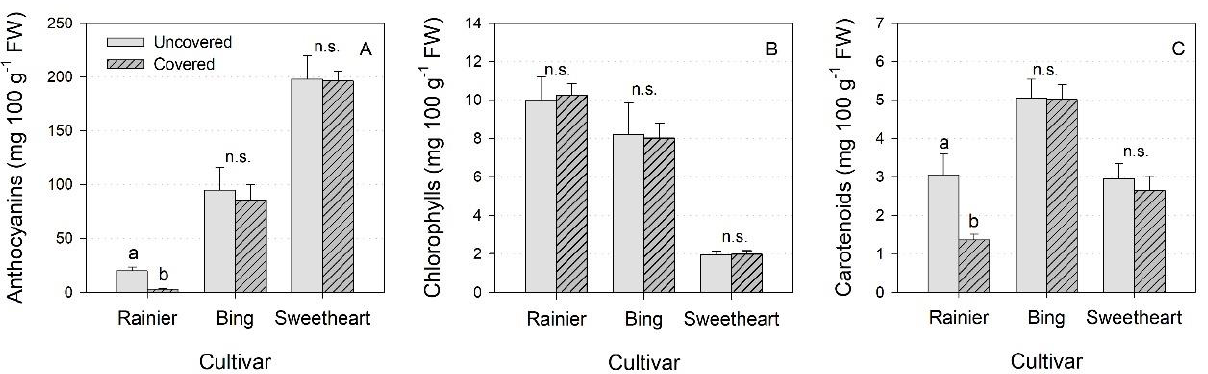
Figure 4. ( A ) Anthocyanin, ( B ) total chlorophyll and ( C ) carotenoid contents of ‘Rainier’, ‘Bing’ and ‘Sweetheart’ sweet cherries with and without rain cover. Columns of a cultivar followed by the same letters indicate no statistical difference between treatments according to Tukey’s test ( p ≤ 0.05). Means + SE ( n = 5).